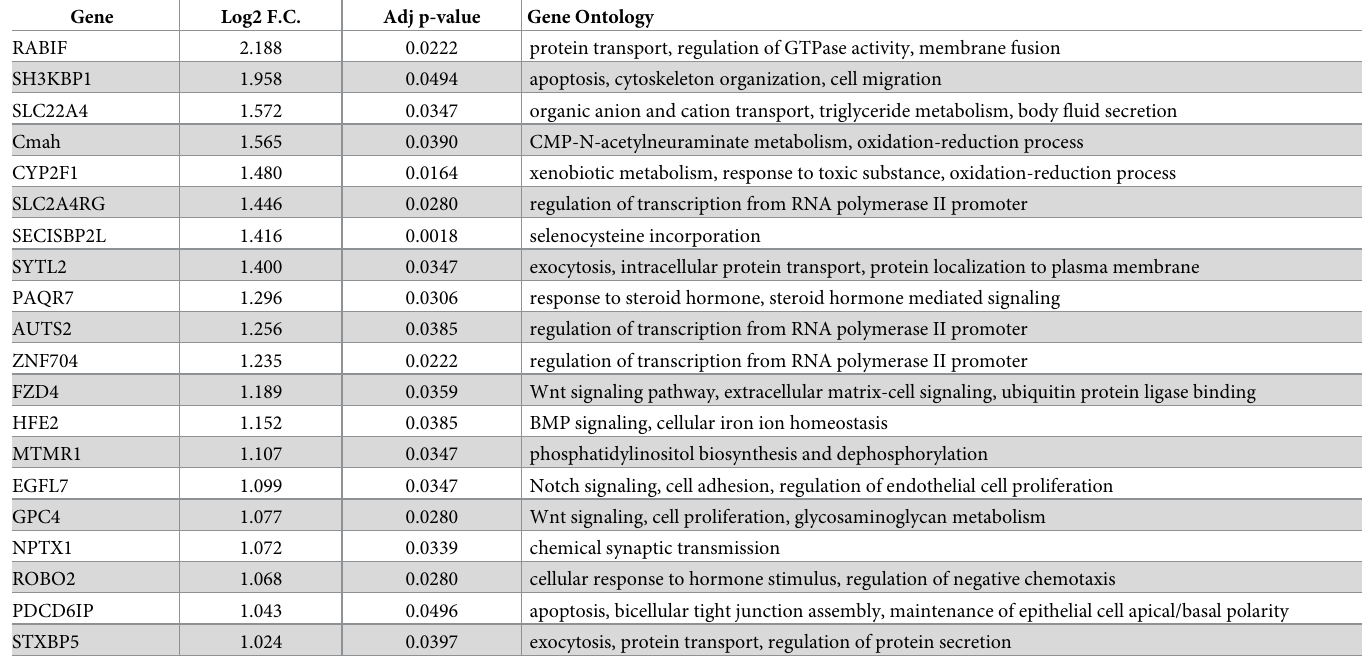
Table 3. Top differentially expressed genes in SIV+ ART adult macaques. Gene Log2